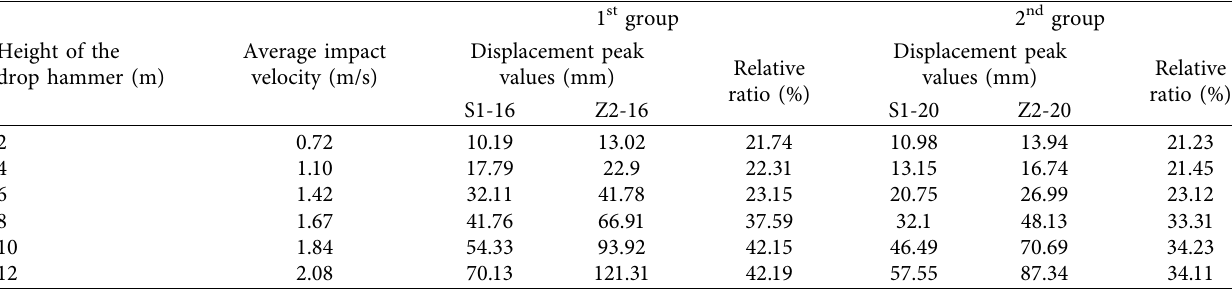
Table 7: Test results and comparison of the top